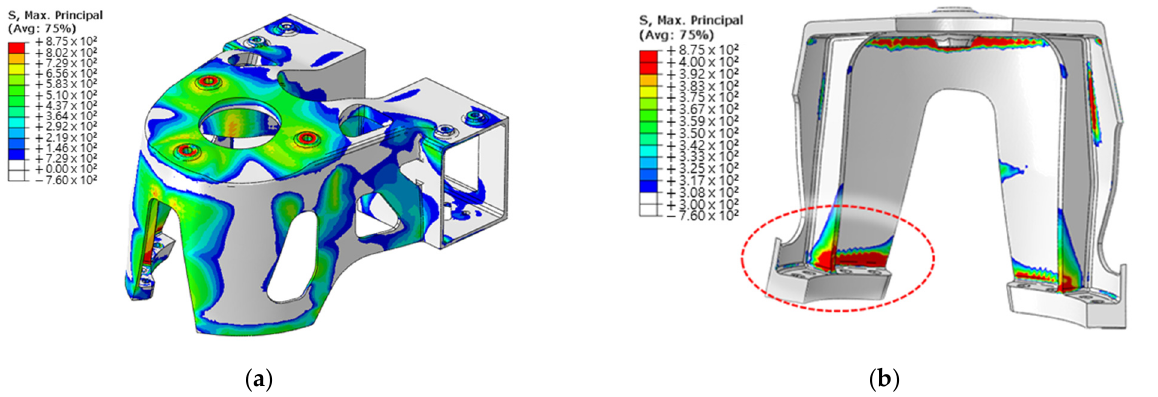
Figure 13. Results of finite element analysis: ( a ) result of maximum stress in the principal axis direction; ( b ) location of stress in excess of tensile strength.